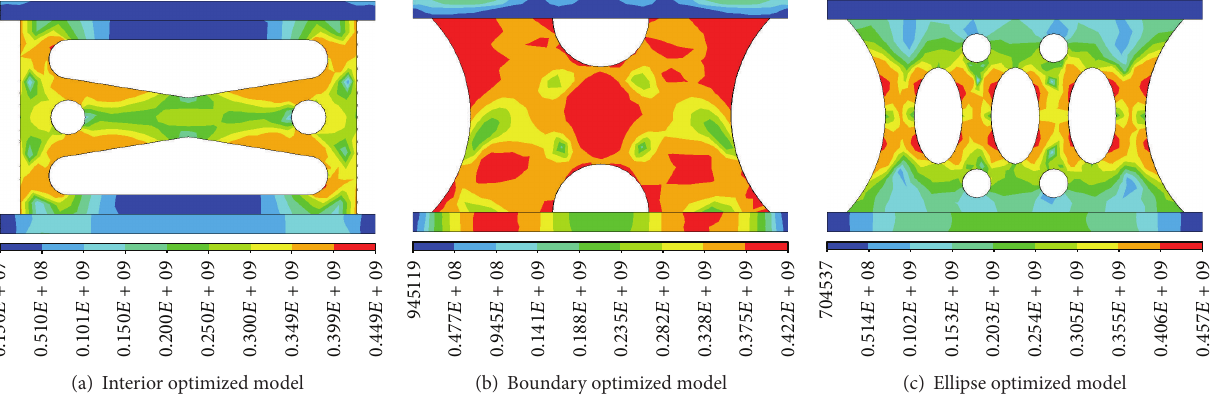
Figure 15: Stress nephogram of Q345 steel plate.